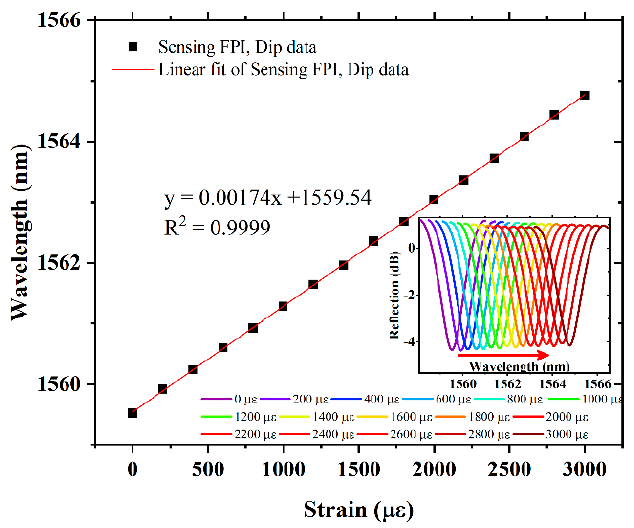
Figure 6. Schematic experimental setup for strain measurements.